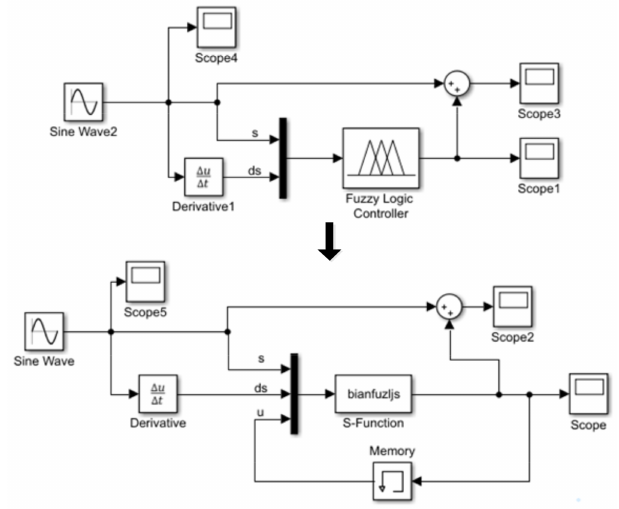
Figure 11. Structure comparison of variable universe FSMC and traditional